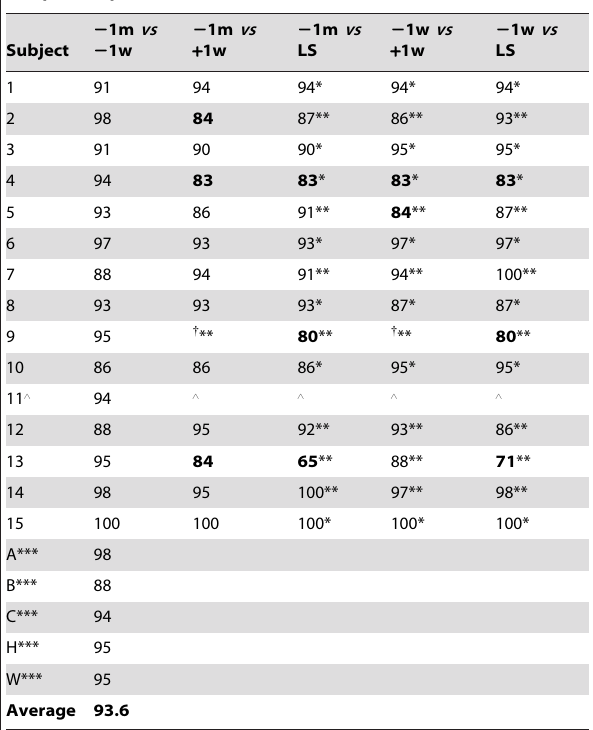
Table 1. Dice similarity coefficients (%) of 16S rRNA amplicon DGGE profiles for fecal samples collected pre- and post- colonoscopy bowel